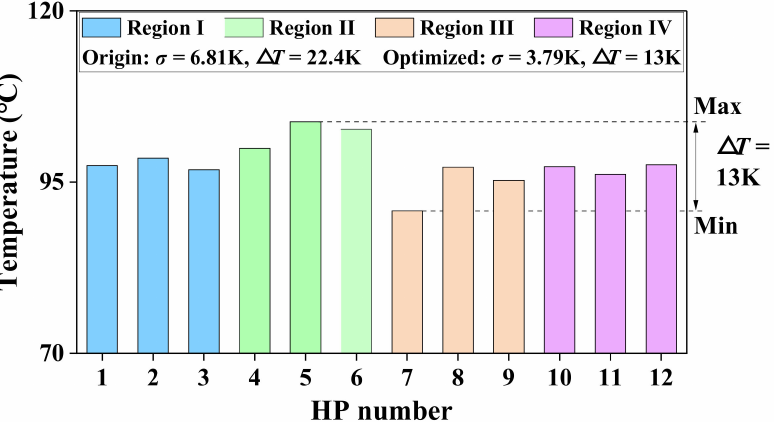
Figure 17. Winding temperature distribution for the new specimen under a current density of 20.6 A/mm 2 and wind velocity of 2.2